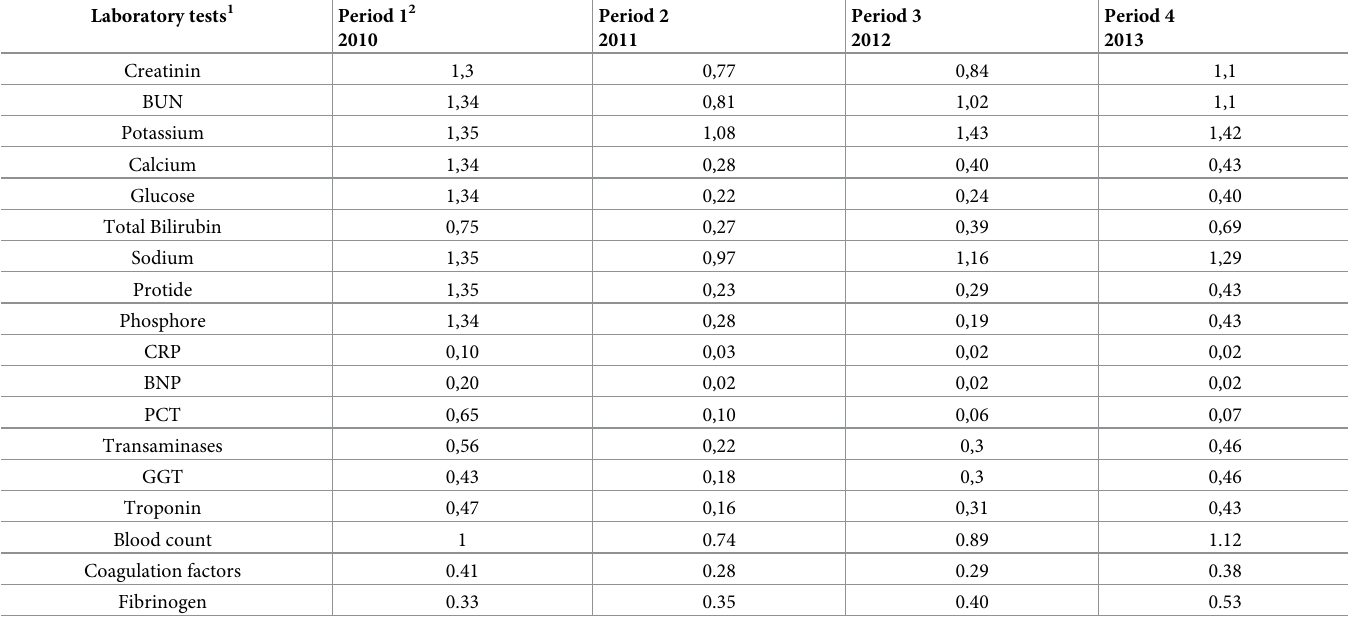
Table 1. Routine demand of main biochemical laboratory tests according to different periods.